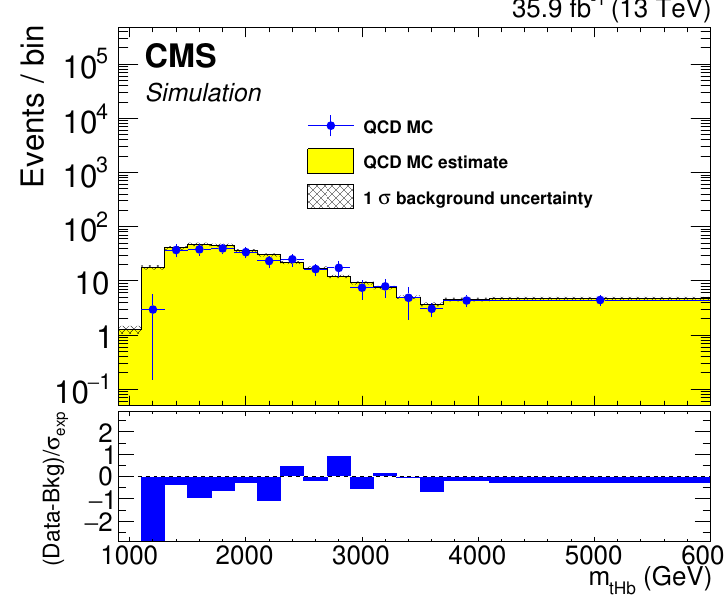
Figure 6 . Reconstructed W mass distributions ( m tHb ) for the simulated QCD events in the 0 signal region for the purposes of validation. The agreement given the systematic uncertainties is at the 1 standard deviation level. The background uncertainty takes into account all systematic and statistical